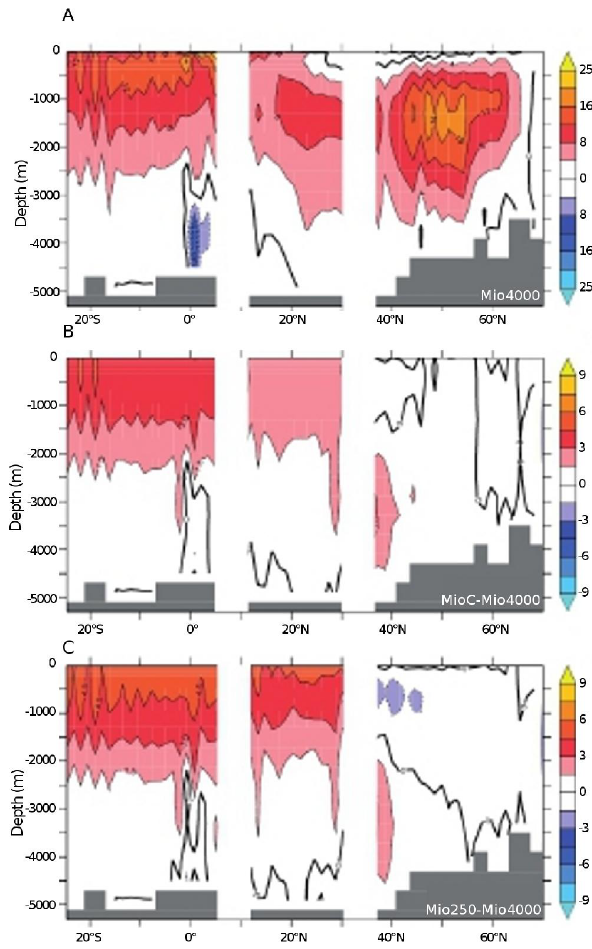
Fig. 9. (A) Simulated Atlantic meridional stream function for Mio4000 experiment. (B) MioC–Mio4000 Atlantic stream function anomaly. (C) Mio250–Mio4000 Atlantic stream function anomaly. Regions where divergence is not equal to zero have been